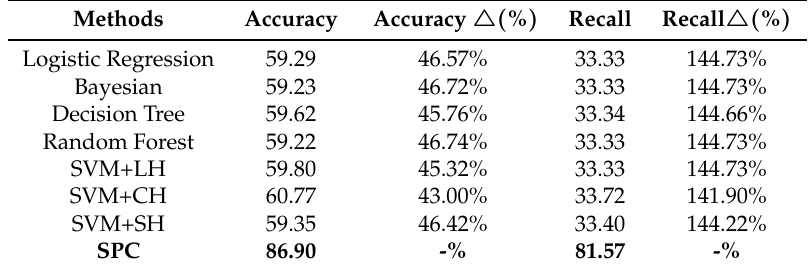
Table 10. Performance comparison of the SPC model with baseline methods on our dataset ( (cid:52) denotes the improvements of SPC over other baseline